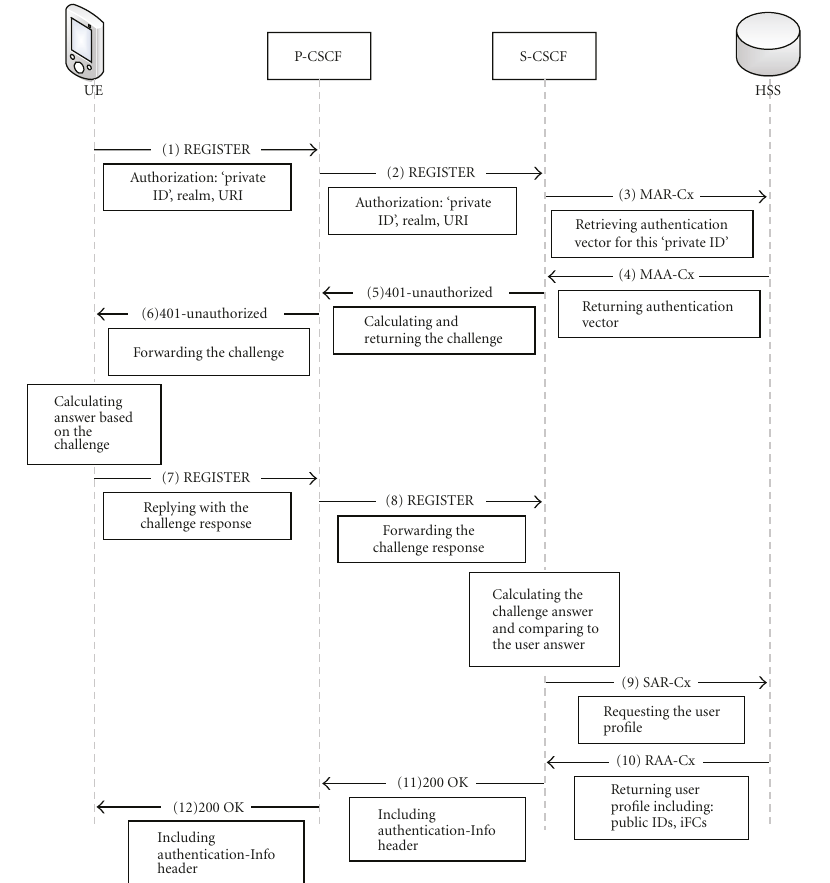
Figure 7: Authentication process based on SIP digest.